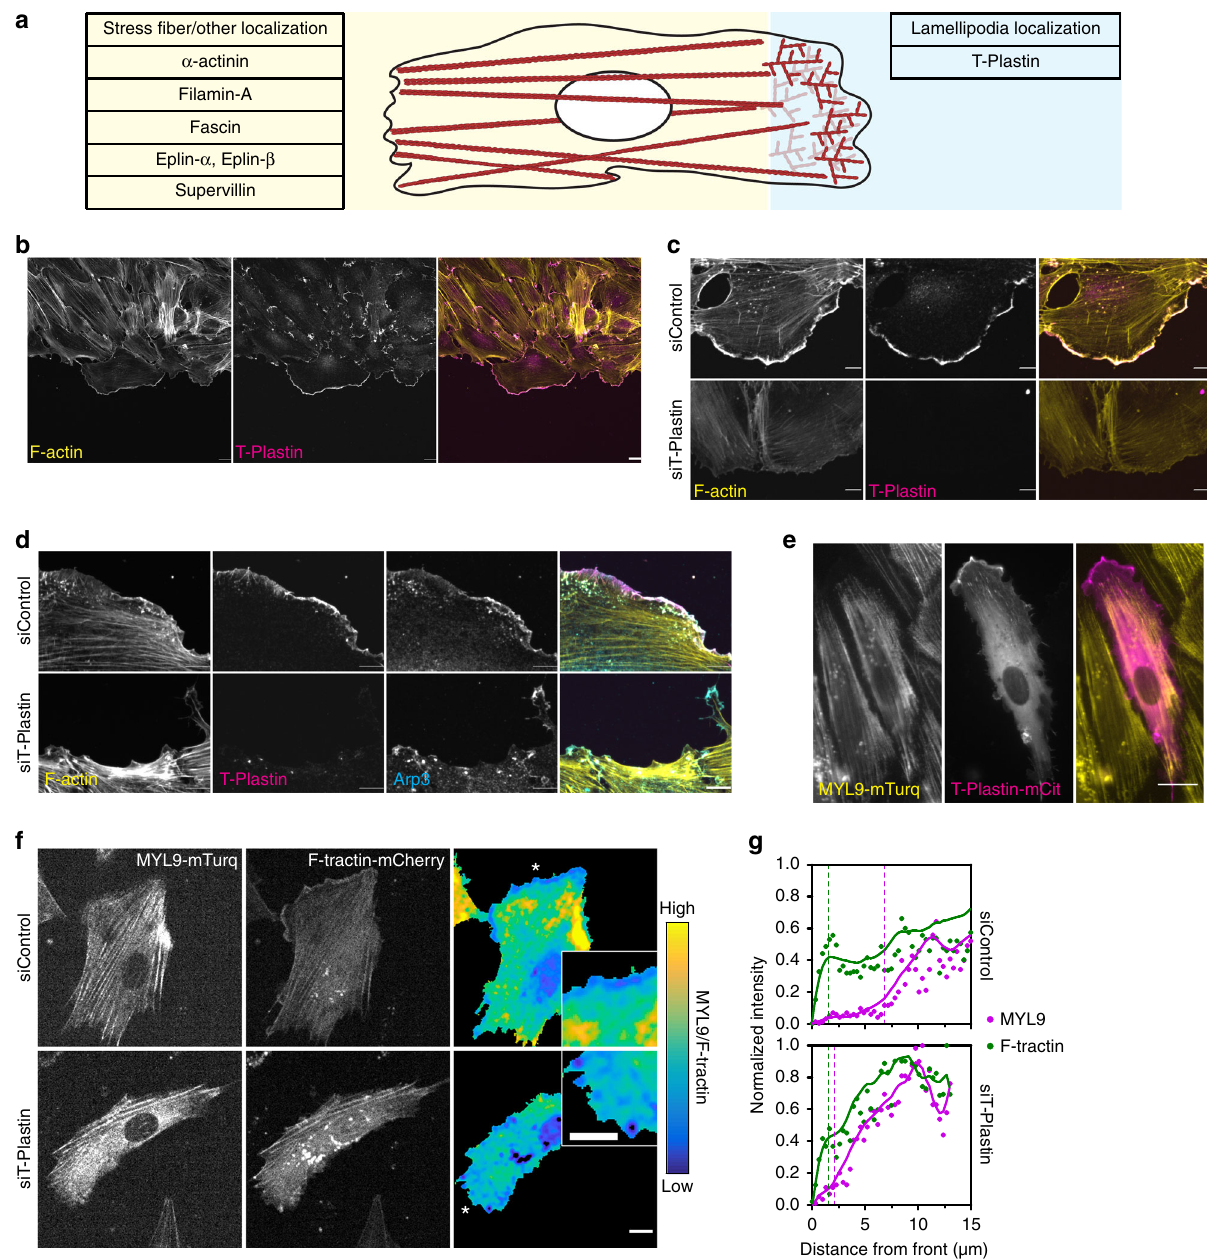
Fig. 2 Mutual exclusivity of T-Plastin and myosin localizations: T-plastin localizes to and regulates the size of lamellipodia. a Localization summary of actin-bundling proteins expressed in endothelial cells (localizations shown in Fig. S2a – c). b Sheets of HUVEC migrating into a scratch stained for F-actin (yellow) and endogenous T-Plastin (magenta), bar 20 µ m. c Cells treated with control or T-Plastin siRNA were fi xed and stained for F-actin (yellow) and endogenous T-Plastin (magenta), bar 10 µ m. d Cells treated with control or T-Plastin siRNA were fi xed and stained for F-actin (yellow) and endogenous T- Plastin (magenta), and Arp3 (cyan), bar 10 µ m. e Cells stably expressing MYL9-mTurquoise (yellow) were transfected with T-Plastin-mCitrine (magenta) and imaged, bar 20 µ m. f Cells expressing F-tractin-mCitrine and MYL9-mTurquoise were treated with control or T-Plastin siRNA and imaged. The ratio of MYL9 over F-tractin is shown as a parula colormap (yellow and blue are 99th (high), 3rd (low) percentiles), bar 10 µ m. g Quanti fi cation of intensities of MYL9 (magenta) and F-tractin (green) along lines drawn from the leading edge into the lamellum of ( n cells for siControl = 9, siT-Plastin = 10, from two independent replicates) as shown in ( f ). Dots represent the median value for each position, lines are LOWESS spline fi ts of the data, and dotted vertical lines indicate regions of actin at leading edge and where myosin activity